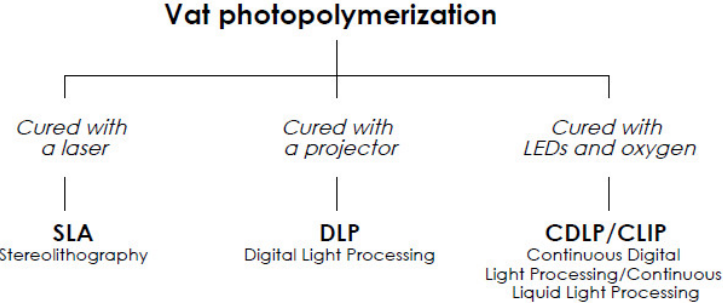
Figure 4. Different curing methods for vat photopolymerization. LEDs: light-emitting diodes.